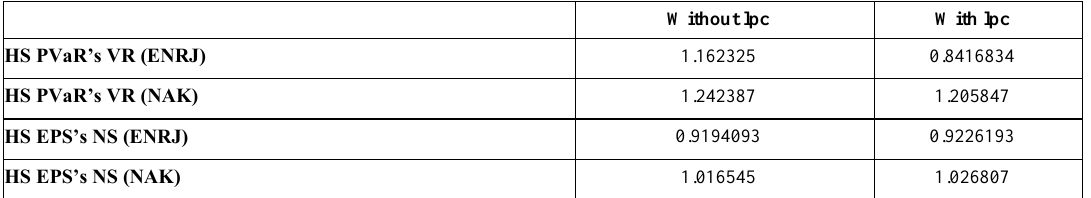
Table 10. Backtest results for Historic Simulation with and without lpc for PVaR and EPS Without lpc With